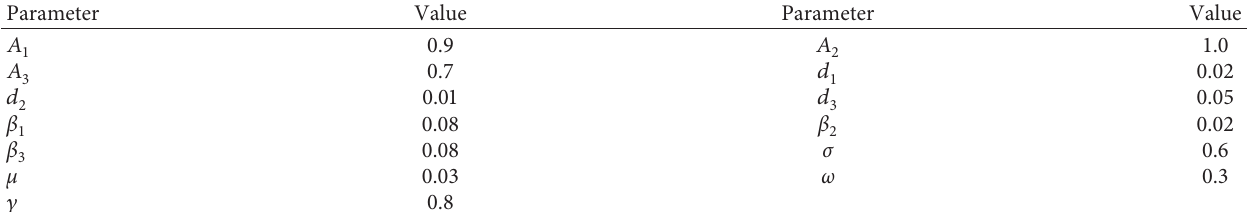
Table 3: List of